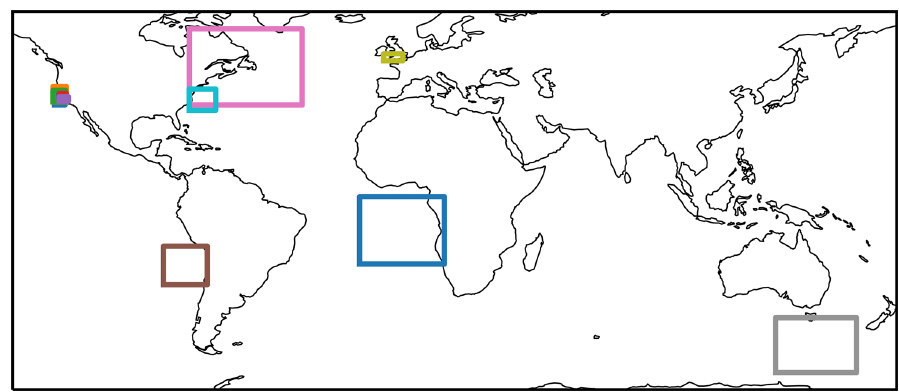
Figure 1. Locations of the campaigns used in this work. Colours are shown in Fig. 2.